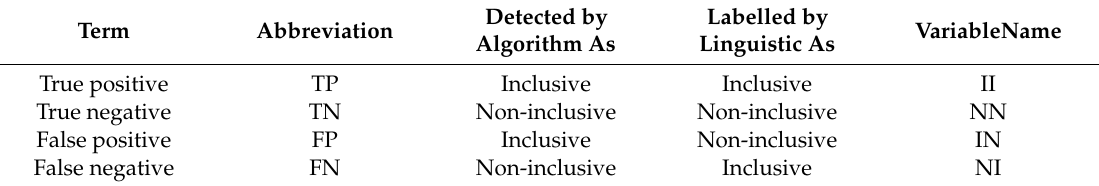
Table 10. Notation